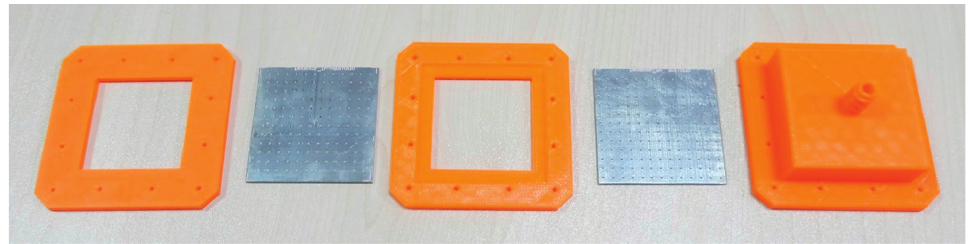
Figure 10: Ion detector customised with printed circuit boards and fixed structure fabricated by 3D printing.